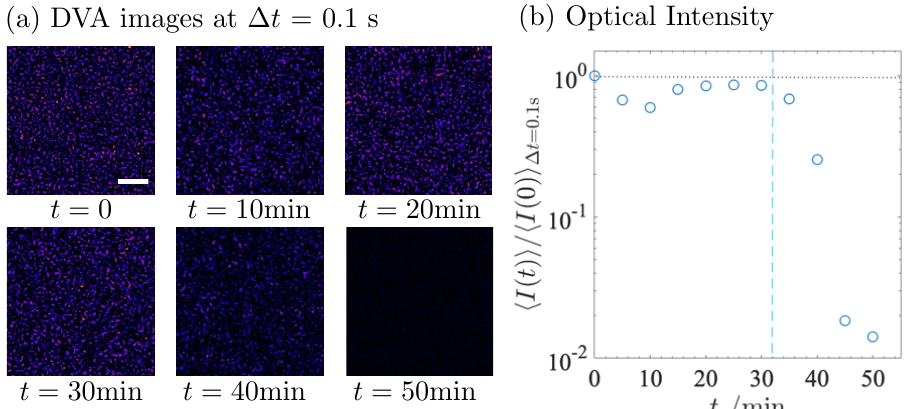
Figure 4. ( a ) DVA images obtained at fixed time-lag ∆ t = 0.1 s at various times t . Scale bar corresponds to 10 µ m. ( b ) Normalized optical intensity (cid:104) I ( t ) (cid:105) / (cid:104) I ( 0 ) (cid:105) ∆ t = 0.1s calculated from DVA images at time lag ∆ t = 0.1 s as a function of t . Vertical dashed line indicates t c = 32